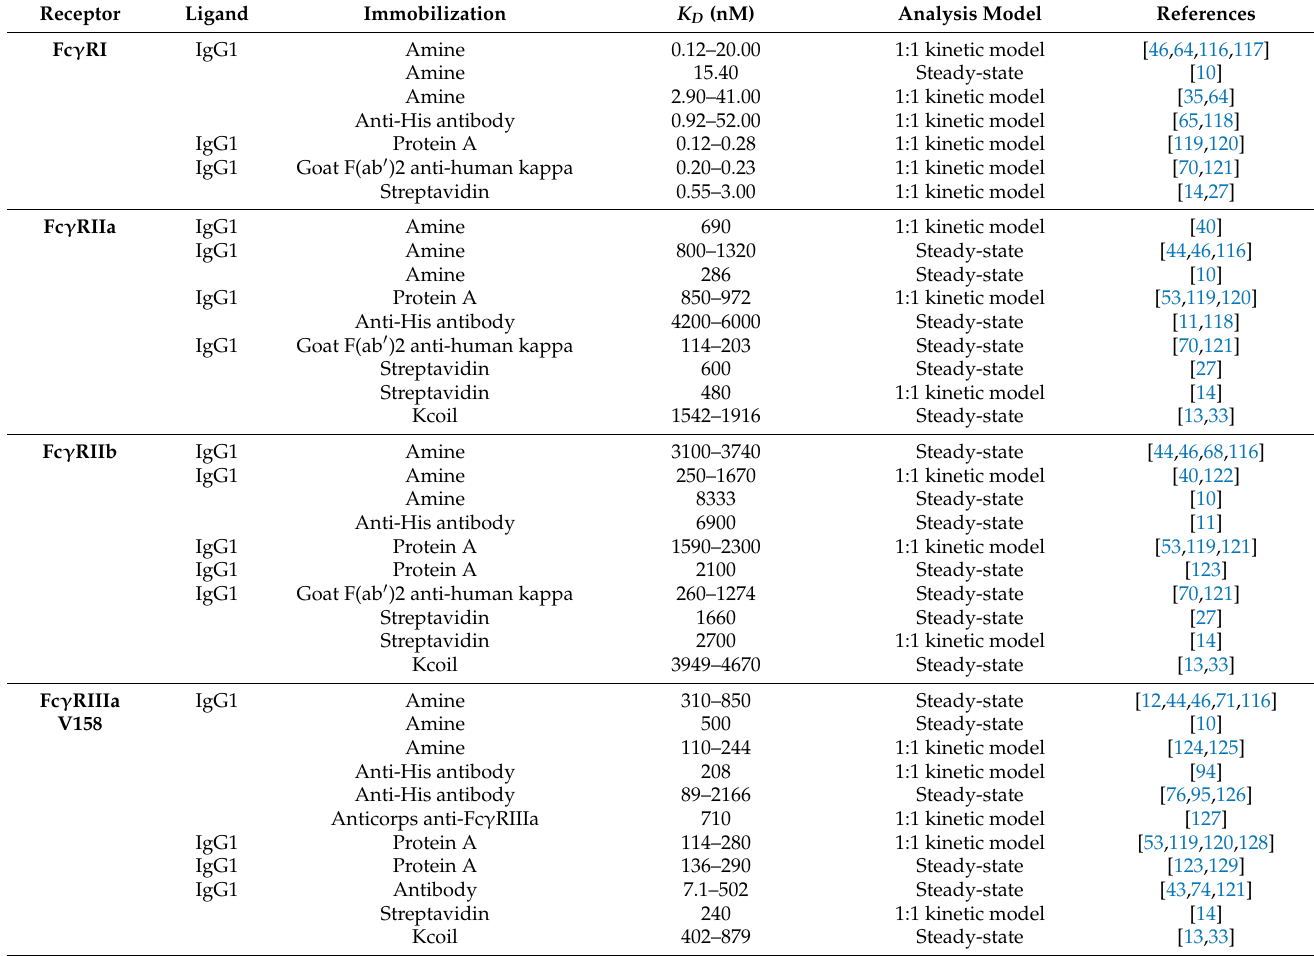
Table A1. Overview of SPR-based experiments to analyze the affinity between IgG1 and Fc γ Rs. Receptor Ligand